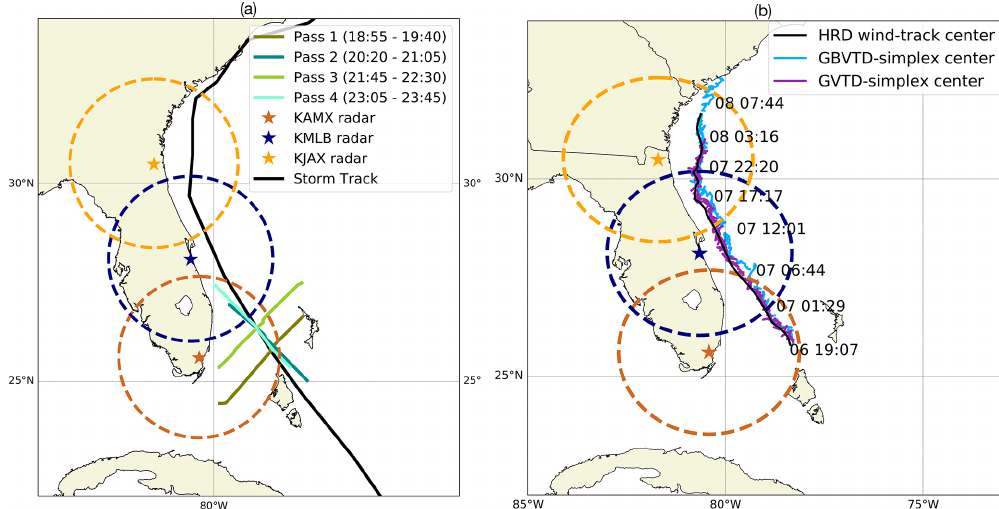
Figure 2. (a) Hurricane Matthew’s center track from best track data (black line) and different radar and aircraft estimates. Passes 1–4 denote the consecutive flight segments of the P3 aircraft across the cyclone on 6 October. Colored circles and stars represent the ground-based radar detecting range (230km) and the location of single-Doppler radar, respectively. (b) Comparison of Hurricane Matthew’s track between the HRD dynamic aircraft center (black line), the GBVTD-simplex center (light blue line), and the GVTD-simplex center (purple line). Colored circles and stars are the same as in panel (a)